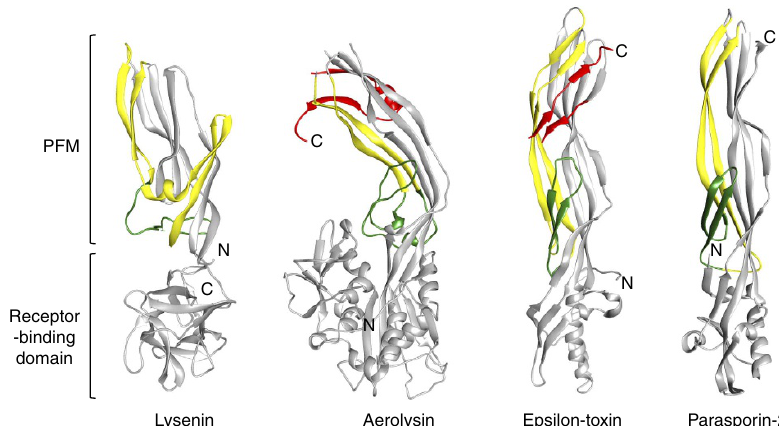
Figure 4 | Conserved mechanism of membrane insertion by the aerolysin family. Comparison of the water-soluble monomeric structure of lysenin with three other members of the aerolysin family. The putative b -barrel-contributing regions in aerolysin (1PRE), epsilon toxin (3ZJX) and parasporin-2 (2ZTB) are coloured in green for the previously thought membrane-insertion loops and yellow for the flanking pre-insertion strands identified in this study. Collectively, these regions form the b -barrel of the lysenin pore. The two pre-insertion strands are typically located on the edge of the toxins and isolated from the main body (grey). In the case of aerolysin and epsilon toxin, the pre-insertion strands participate in b -sheets with the CTPs (red), thus stabilizing the soluble monomeric state. In parasporin-2, the N-terminal peptide, which was not present in the crystal structure of the activated toxin, has the greatest effect on toxin activity, and was hypothesized to interact with the insertion loop, thus acting as a safety-lock 5 .